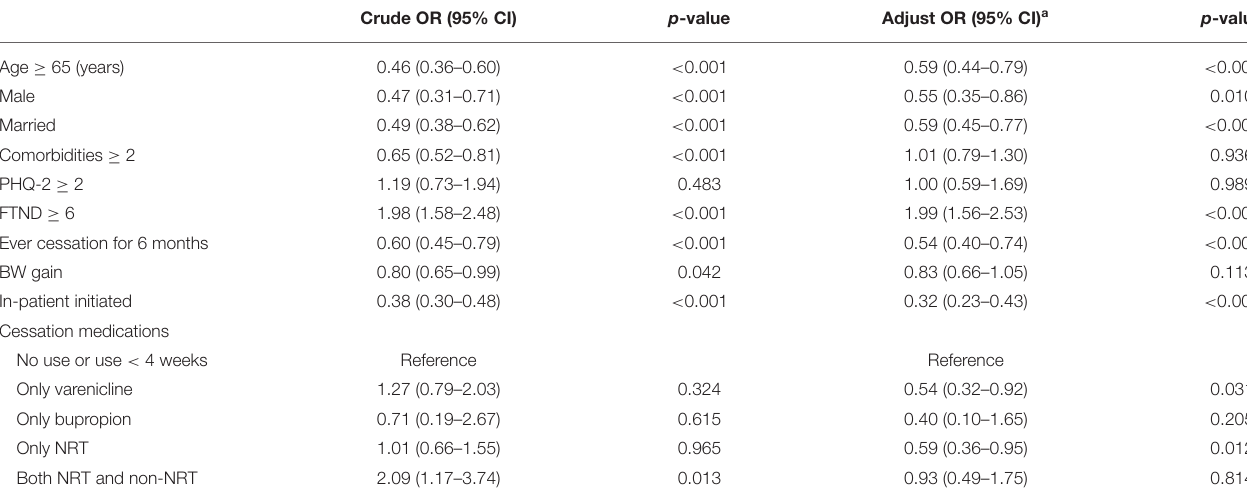
TABLE 2 | Univariable and multivariable logistic regression for predictors of failed 6-month smoking abstinence for all the participants ( n = 1475).